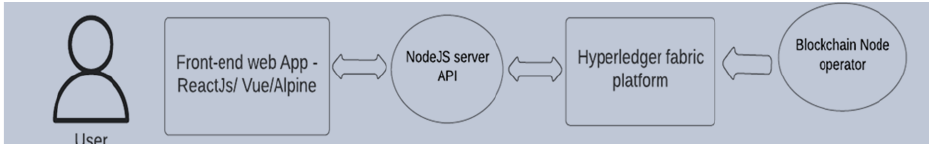
Figure 7. Schematic technology stack.